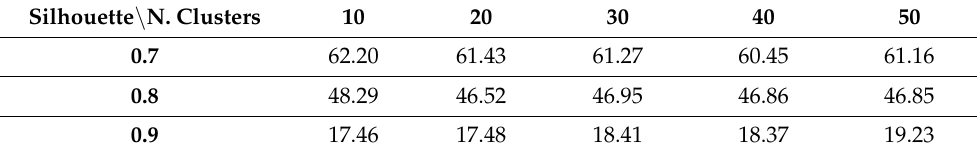
Table 38. Clustering performance in terms of silhouettes using the reduced dataset with PCA. Silhouette \ N. Clusters